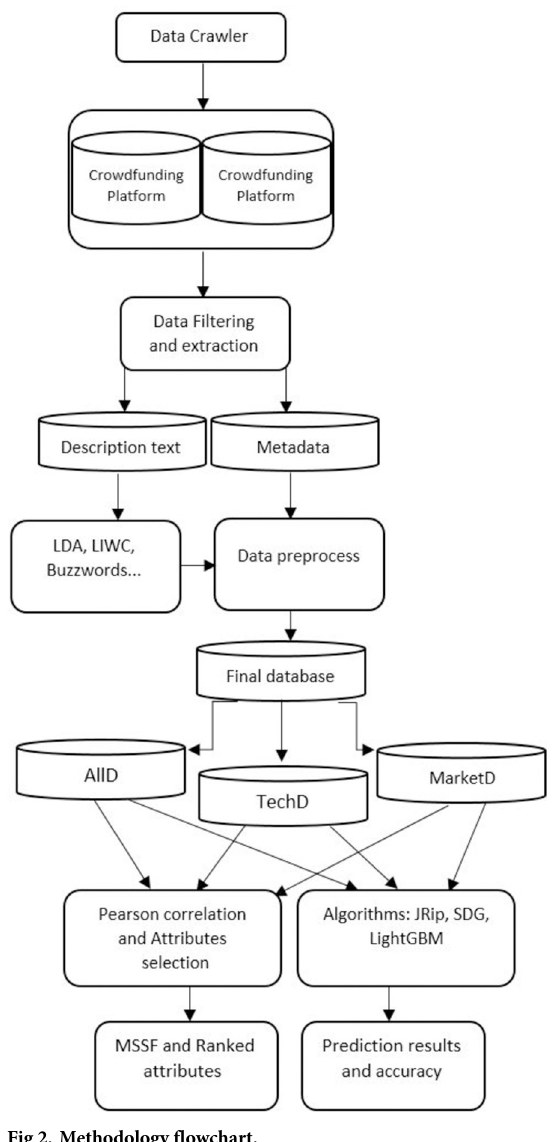
Fig 2. Methodology